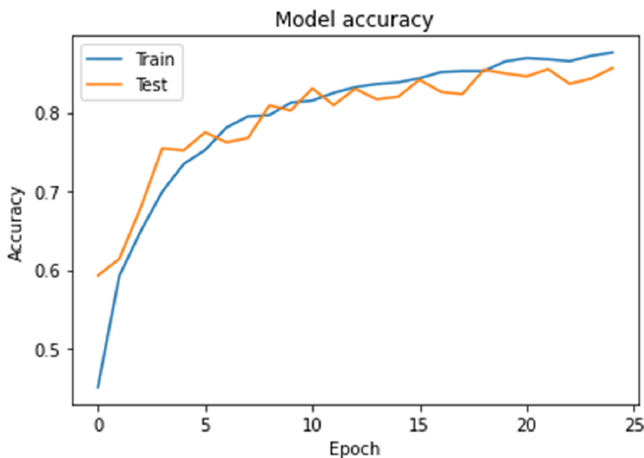
Figure 7. Plot of training and testing accuracy with regard to each epoch.